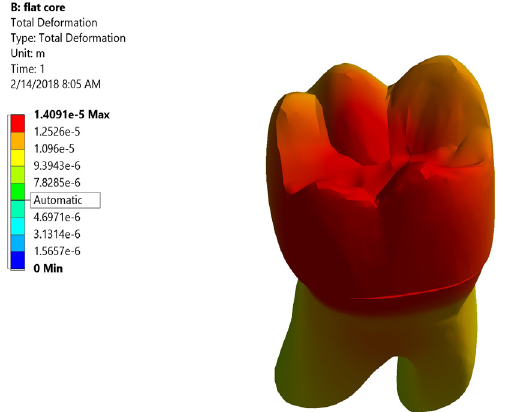
I.Figure 9. Color graphics showing total deformation of Group